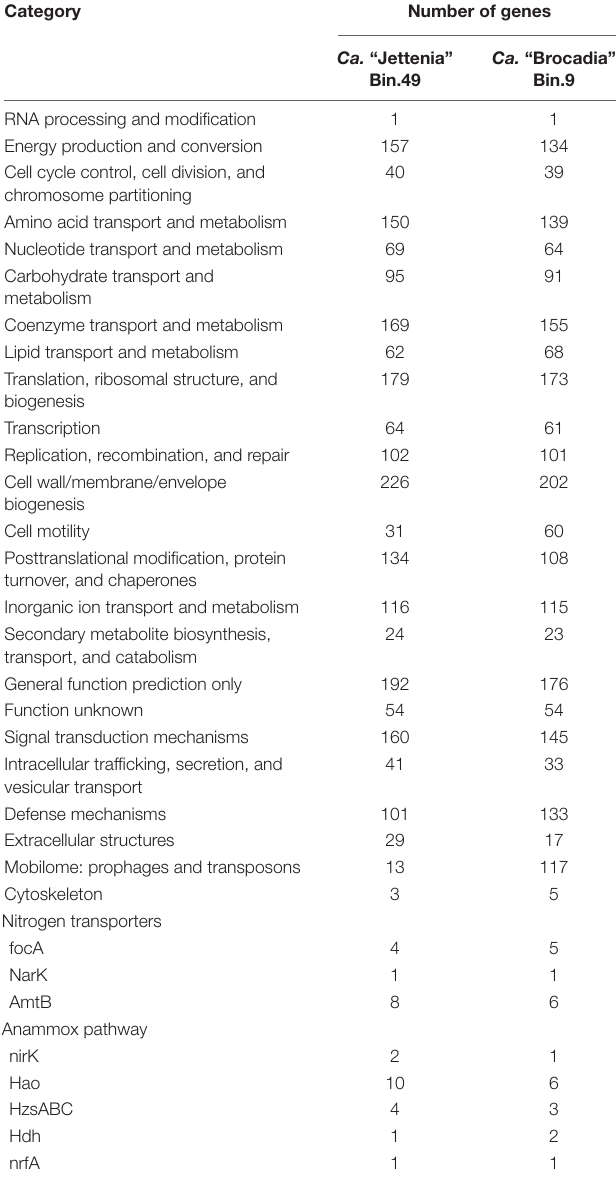
TABLE 1 | Comparative analysis of functional gene numbers on the COG class level between Ca. “Brocadia” and Ca. “Jettenia”